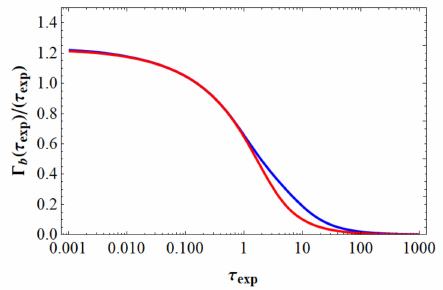
(cid:0) (cid:1) τ exp / τ exp as a blue line and for comparison